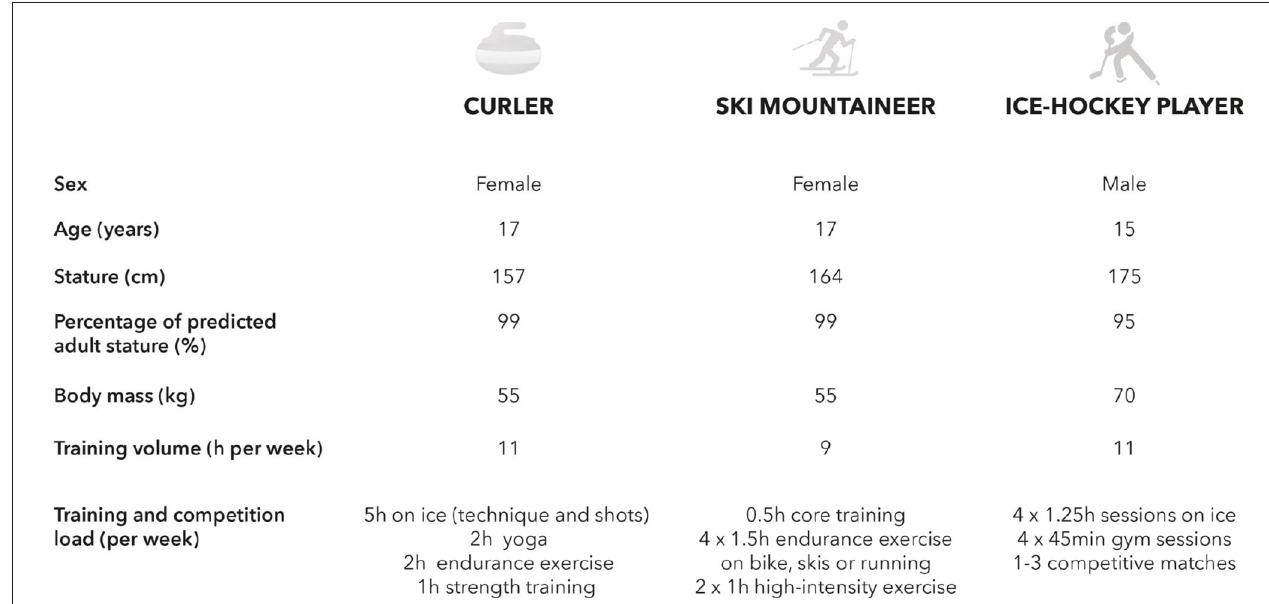
FIGURE 1 | Sex, age, anthropometric characteristics and typical training schedule of a curler, ski mountaineer, and ice hockey player competing in the Lausanne 2020 Youth Olympic Games. The differences in anthropometric profile and training and competition loads between athletes likely result in differences in total energy expenditure and thus energy requirements. Data were kindly provided by the athletes and their coaches via a personal communication to V.